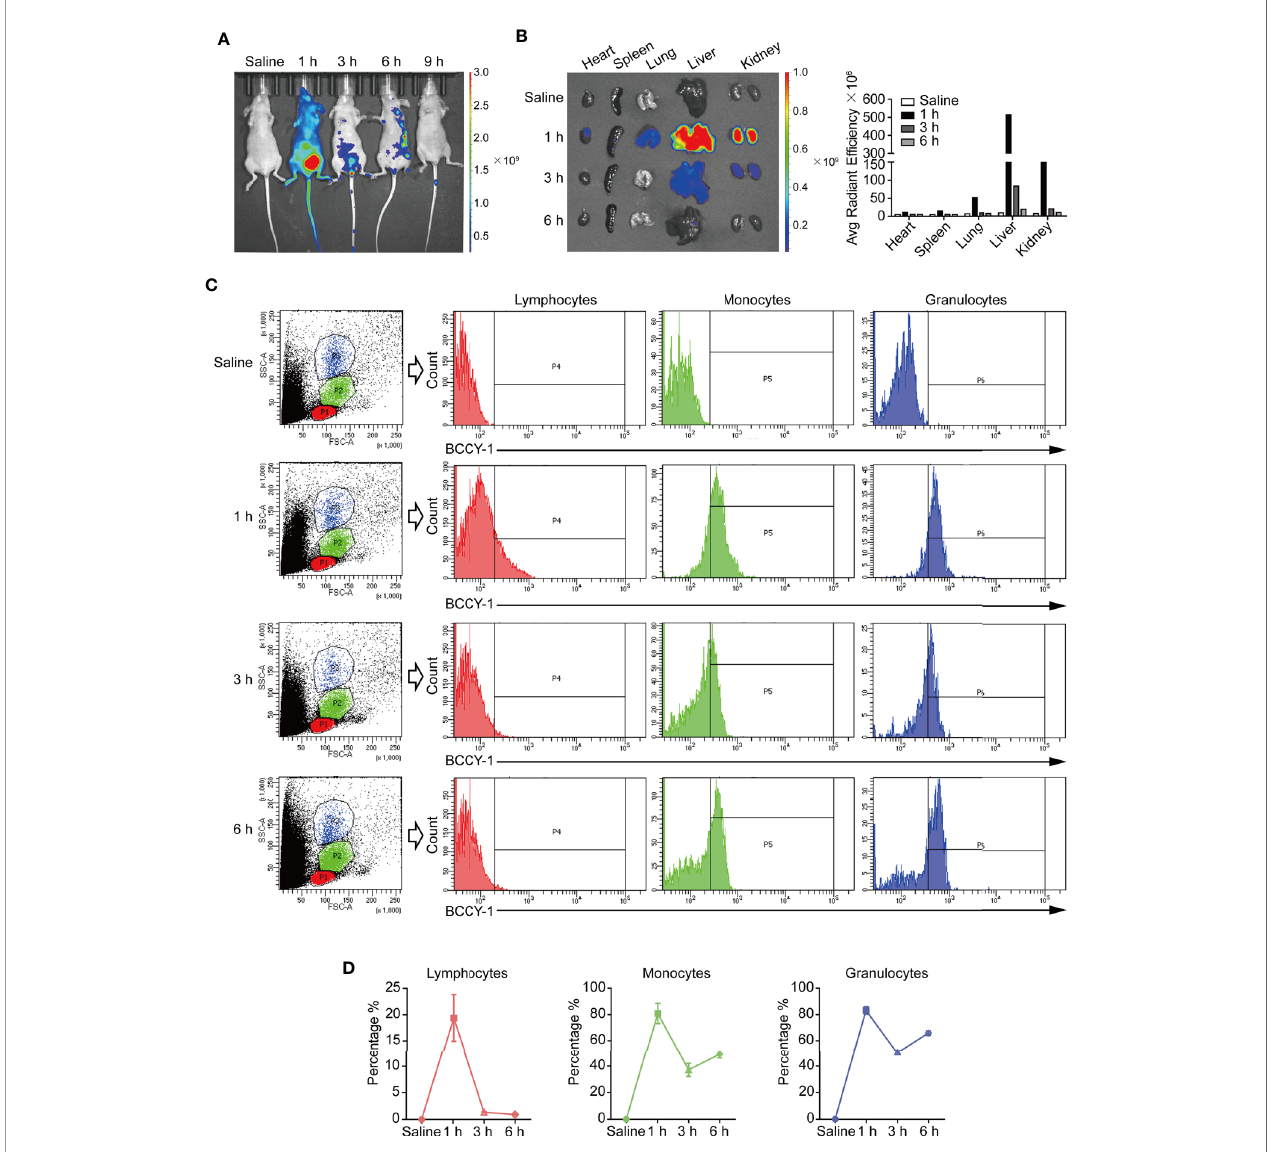
FIGURE 2 | In vivo biodistribution analysis of BCCY-1. (A) In vivo imaging of mice and (B) ex vivo imaging of major organs at indicated hours after TAMRA-BCCY-1 treatment. Average radiant ef fi ciency ([p/s/cm 2 /sr]/[ m W/cm 2 ]) was quanti fi ed at indicated time points. (C, D) The biodistribution of BCCY-1 in peripheral blood cells (lymphocytes, monocytes and granulocytes) was analyzed by fl ow cytometry at indicated hours. The percentage of TAMRA positive cells in the indicated cell population was quanti fi